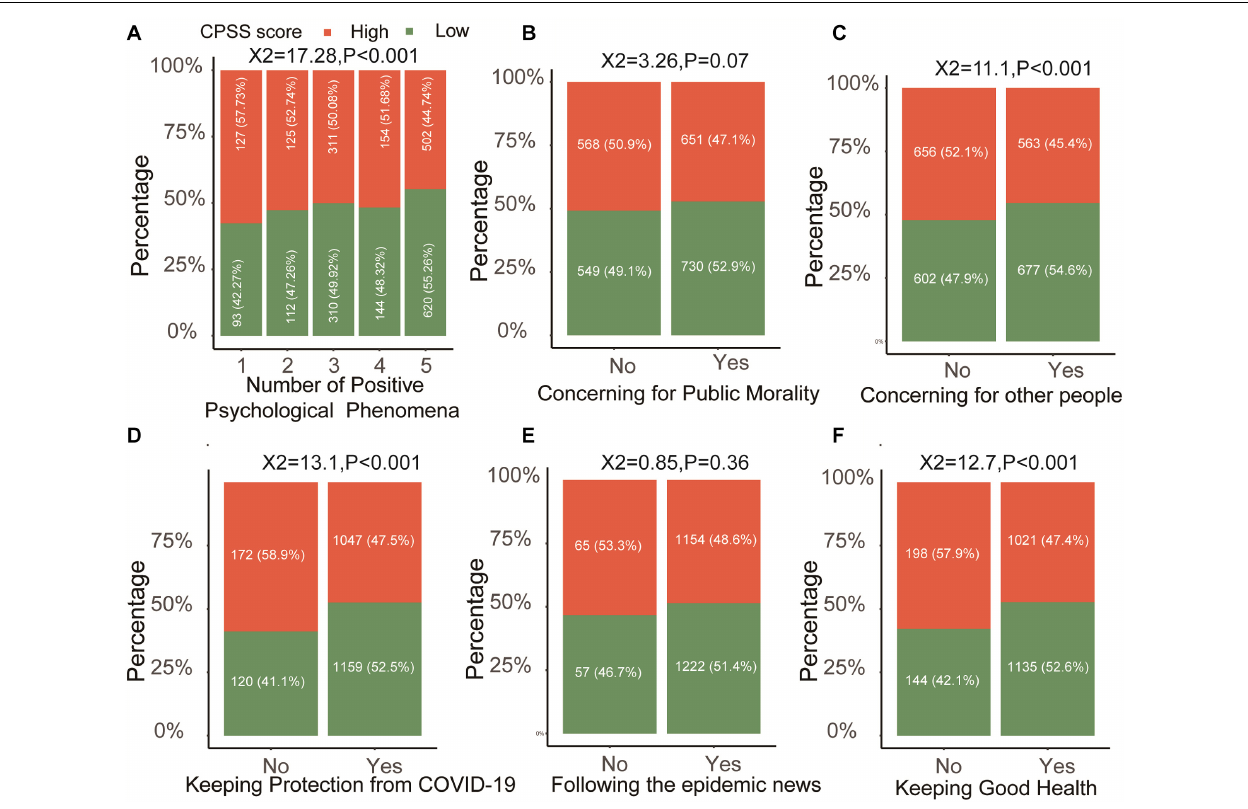
FIGURE 4 | The relationship between CPSS score with different positive psychological phenomena in medical students. (A) The trend of the number of positive psychological phenomena in high or low CPSS score groups. (B–F) The individual positive psychological phenomenon.